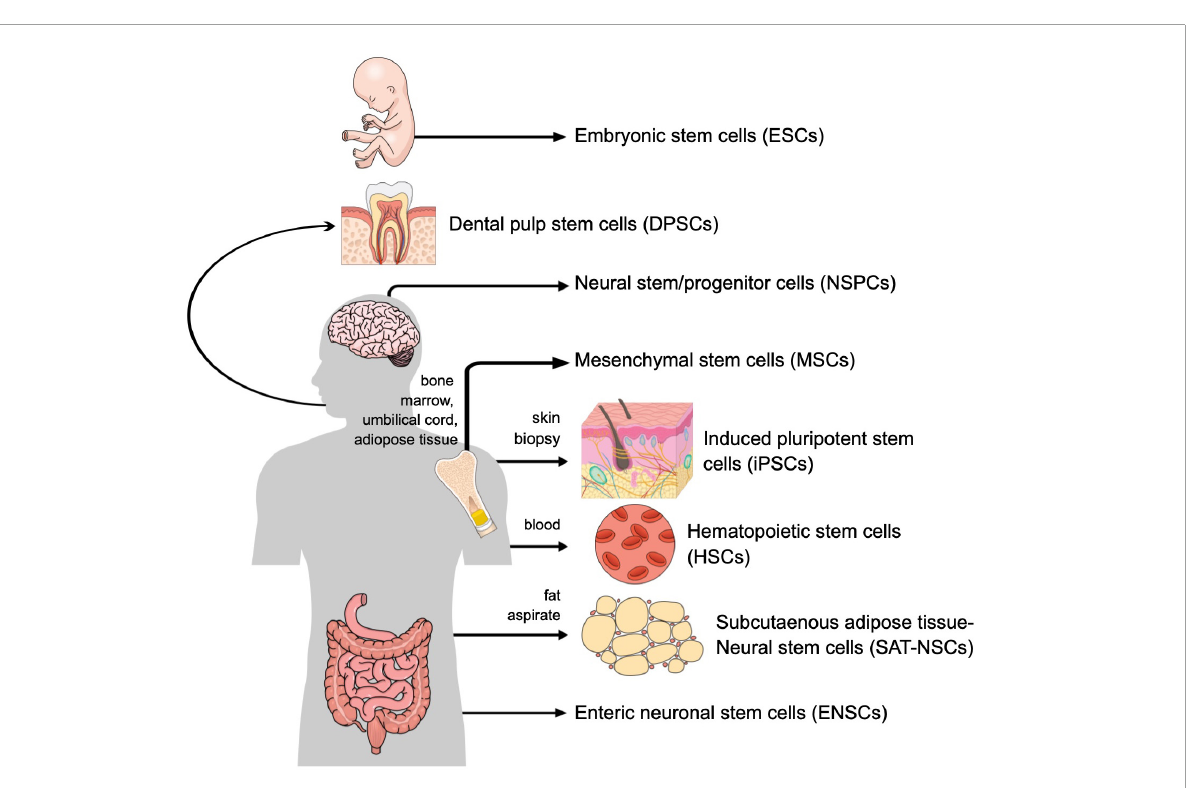
two alternative sources of autologous cells for CNS repair, both directly derived from the peripheral nervous system and therefore with intrinsic neurogenic potential: enteric neuronal stem cells (ENSCs) and neural crest-derived Schwann cells found in subcutaneous adipose tissue (termed